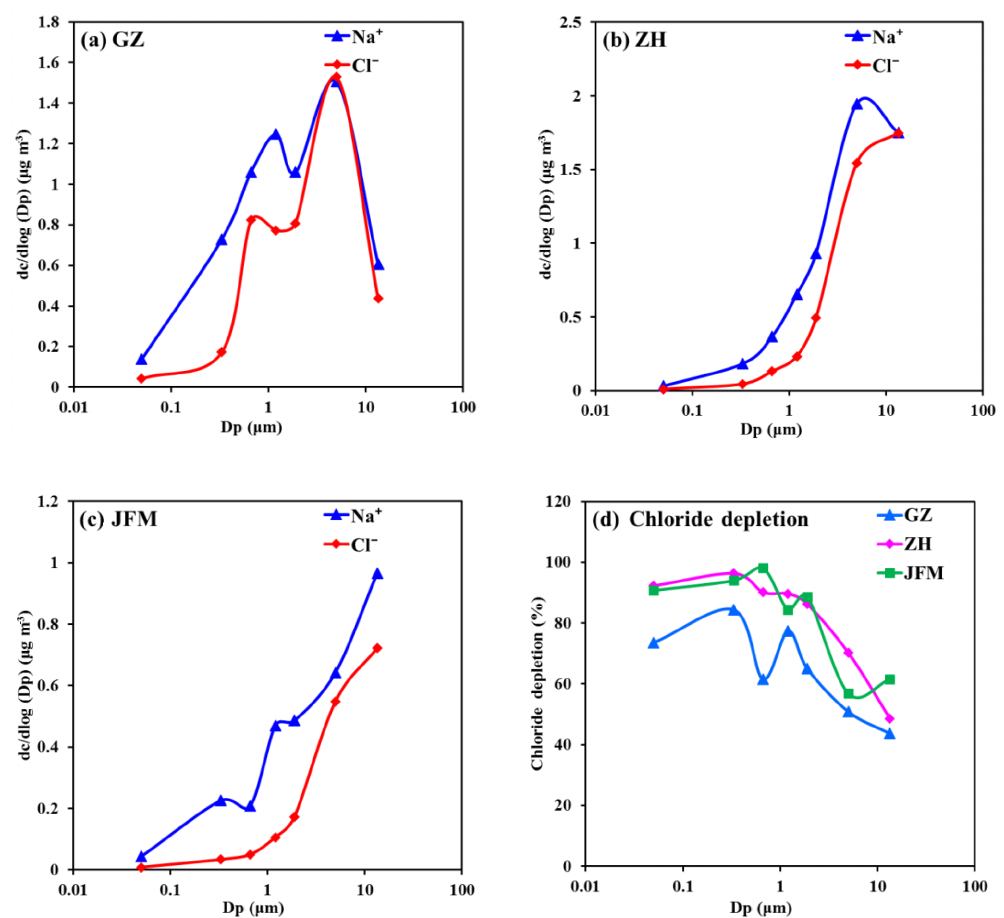
Figure 5. The mass size distribution of (a–c) Na + and Cl − and (d) percentage of chloride depletion at the three